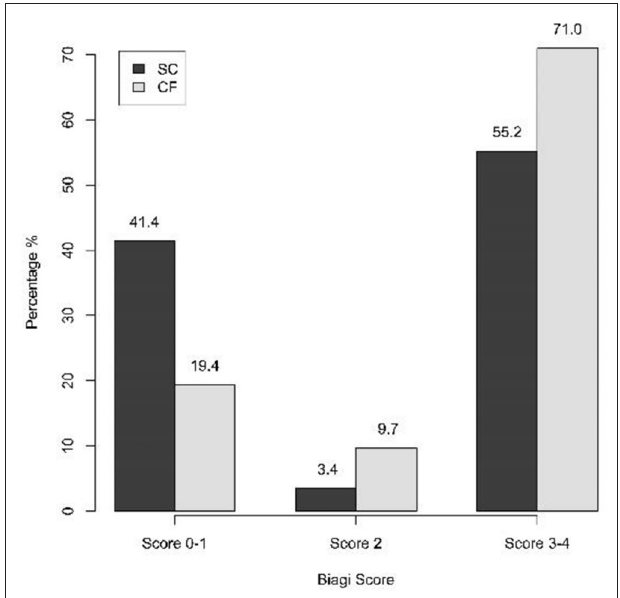
FIGURE 3 | Compliance to the GFD in the SC-group and in the CF-group assessed through the Biagi score (three-category analysis) ( p = 0.143). SC, screen-detected (group); CF, case-finding (group).